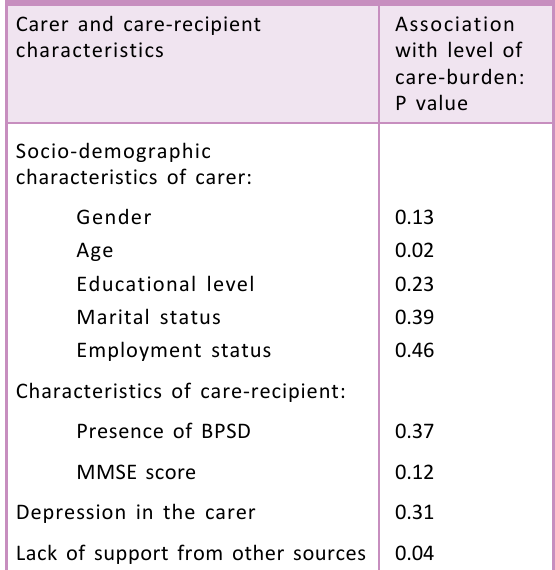
Table 2. Associations between socio-demographic and patient factors and level of care-burden